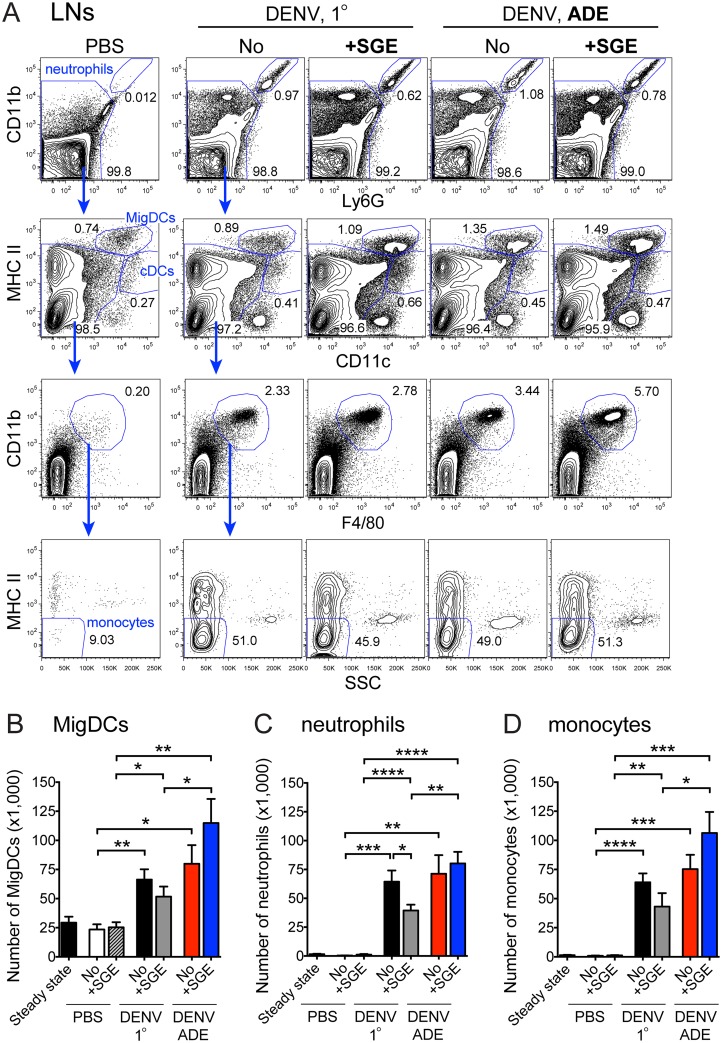
SGE accelerates migration of dendritic cells and recruitment of neutrophils and monocytes to lymph nodes during ADE.Mice were inoculated i.d. with PBS or 105 PFU DENV under 1° or ADE conditions in the presence or absence of SGE. (A) Contour plots showing cells in LNs 14 h after inoculation. Consecutive gating identified neutrophils as Ly6G+ CD11bhi, MigDCs as Ly6G- CD11cint MHCIIhi, cDCs as Ly6G- CD11chi MHCIIint, and monocytes as Ly6G- CD11c–/low MHCII-CD11b+ F4/80+. For expression of CCR7 and Fcγ receptor, see S4 Fig. Bar graphs summarizing the number of MigDCs (B), neutrophils (C) or monocytes (D) in LNs. Data are representative (A) or pooled (B-D) from three experiments, n = 6–9 per group. Statistically significant differences between groups are marked as * for p<0.05, ** for p<0.01, *** for p<0.001, and **** for p<0.0001.